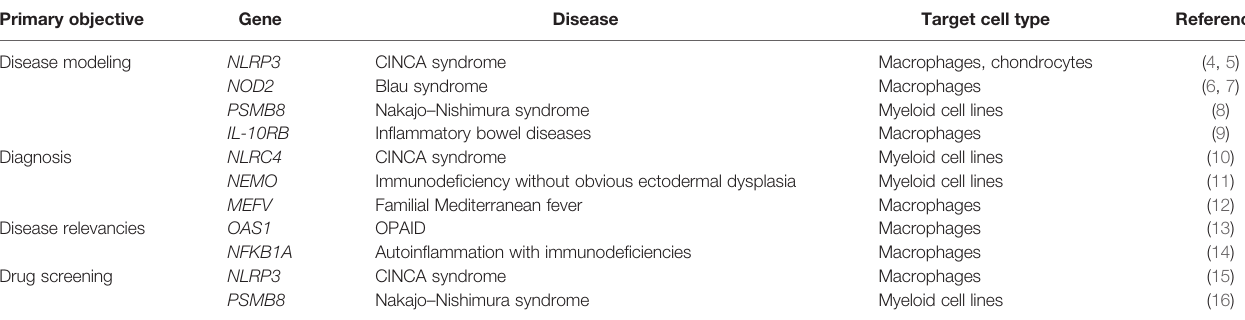
TABLE 1 | Disease modeling and application of iPSCs to autoin fl ammatory diseases. Primary